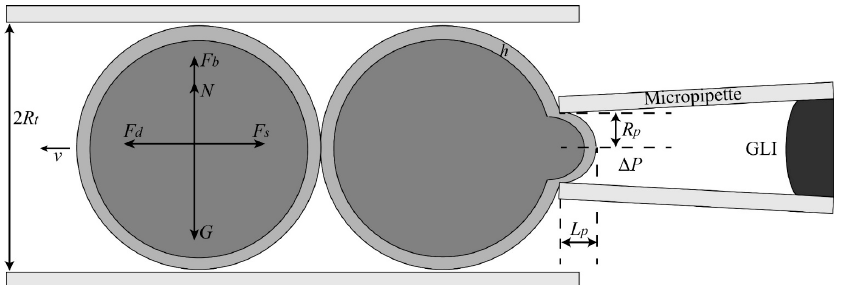
Figure 7. Schematic figure of force analysis when drawing back the other cell from the held cell.